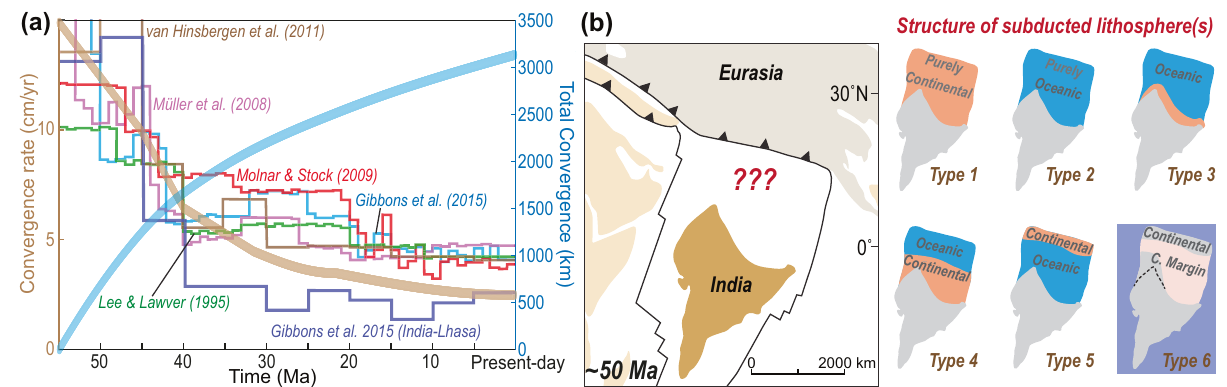
Fig. 1 | Proposed structures for the subducted lithosphere that was between IndiaandTibetintheearlyEocene.a TheconvergencehistorybetweenIndiaand Eurasia in different plate reconstructions 11 – 15 . The thick brown line illustrates the average convergence rate of these different studies, and the thick blue line shows the corresponding total convergence. b Early Paleogene position of the Indian Subcontinent with different hypotheses (or model types) for the nature and structure of the ‘ lost ’ lithosphere between India and Tibet 1,2,4,11,17,20 – 22 . Based on the numericalmodelinginthisstudy(alsoinLiuetal.,2021a 44 ),theexternalterranewas